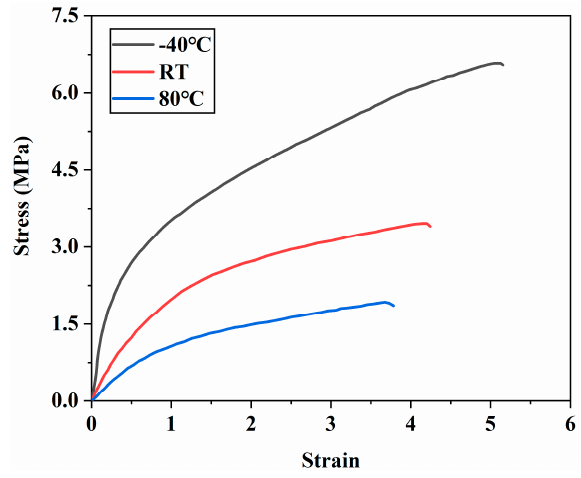
Figure 9. Stress-strain curve of adhesive. Table 11. Young’s modulus, tensile strength and failure strain of adhesives at − 40 °C, RT and 80 °C. Temperature ( ◦